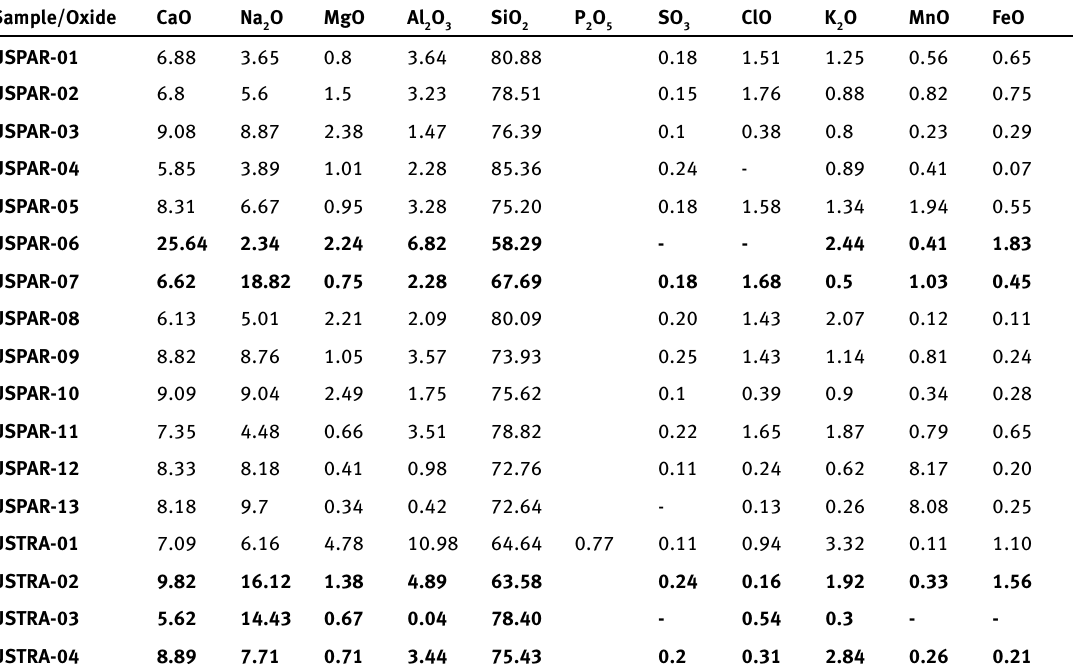
Table 5a: Major elements in wt% of oxides by EPMA-EDS ( Unaltered ; Altered).